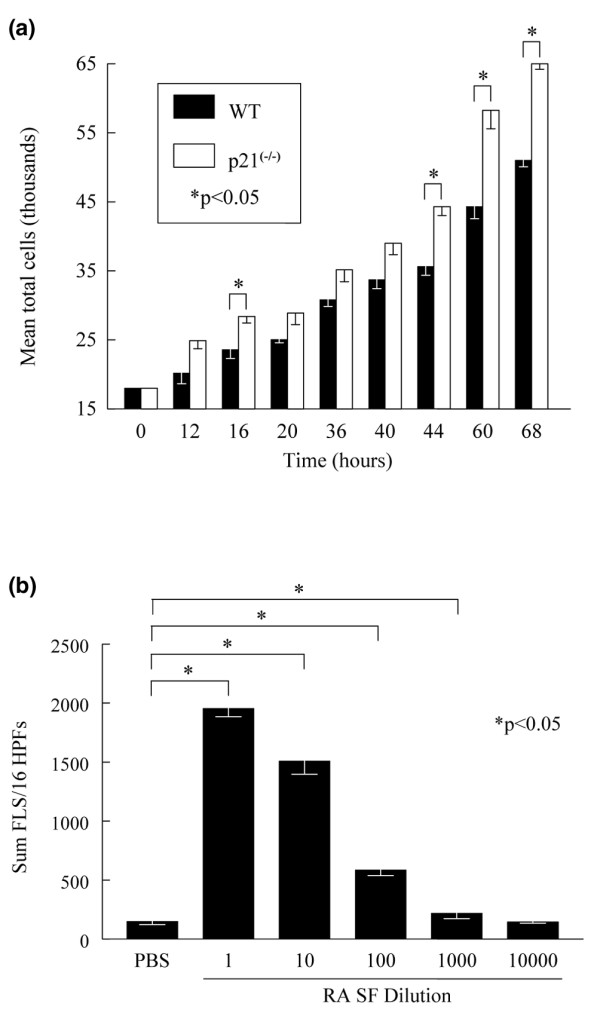
p21(-/-) fibroblast-like synoviocytes (FLS) exhibit a faster growth rate than wild-type (WT) FLS, while both cell types migrate in a dose-dependent manner to rheumatoid arthritis (RA) synovial fluids (SFs). (a) Equal numbers of WT or p21(-/-) FLS were plated into a 24-well plate and allowed to grow. At various time points, cells were removed and quantified as described in the Materials and methods section. Bars represent the mean of triplicate wells ± standard error (SE). An asterisk indicates a statistically significant difference. (b) WT FLS were tested for their ability to migrate to different dilutions of RA SF. The sum of counts from three high power fields (HPFs) was determined, and bars represent the mean of those sums from quadruplicate wells ± SE. An asterisk indicates a statistically significant increase in chemotaxis relative to background migration to PBS.